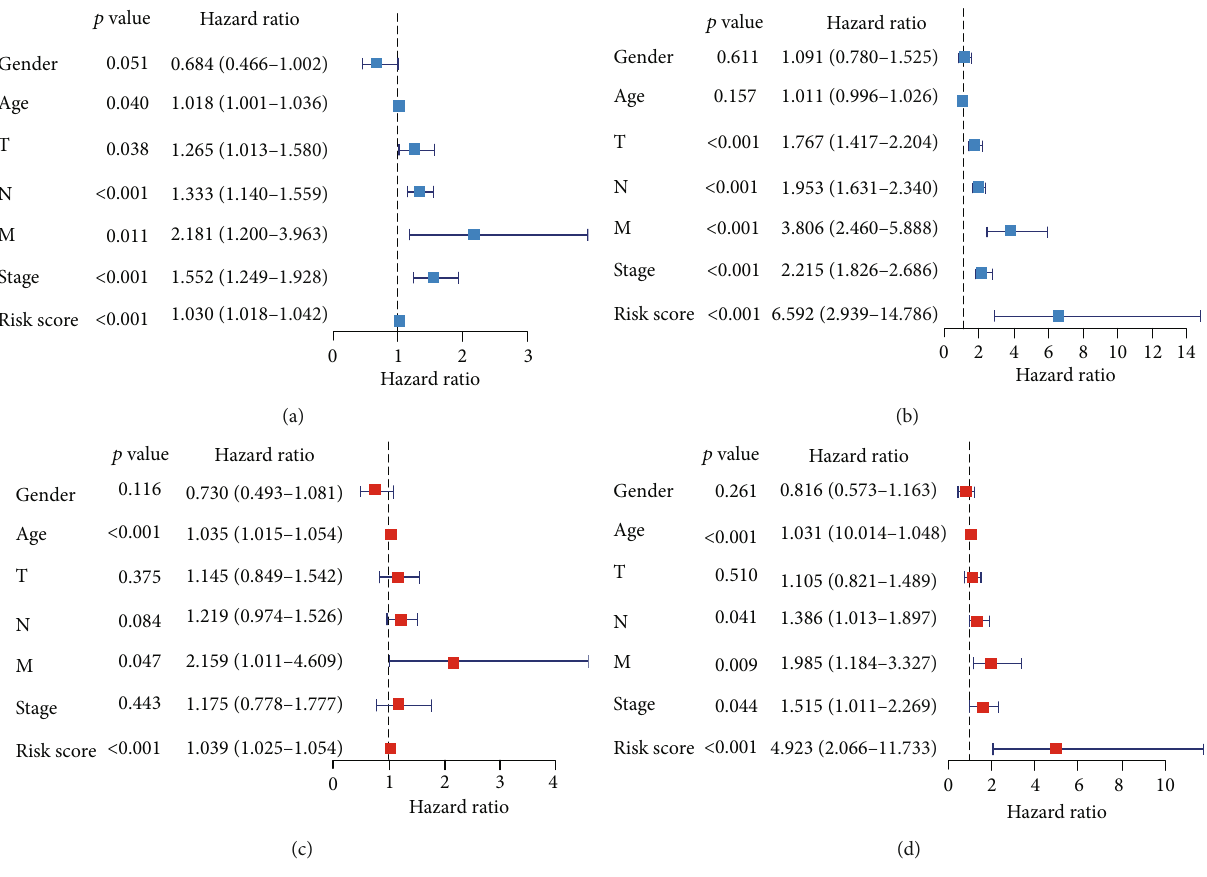
Figure 6: Independent prognostic value analysis. (a, c) Univariate and multivariate Cox analyses in TCGA dataset. Risk score is an independent prognostic factor for gastric cancer patients ( P < 0 : 01 ). (b, d) Univariate and multivariate COX analyses in the GSE62254 dataset. Risk score is an independent prognostic factor for gastric cancer patients ( P < 0 : 01